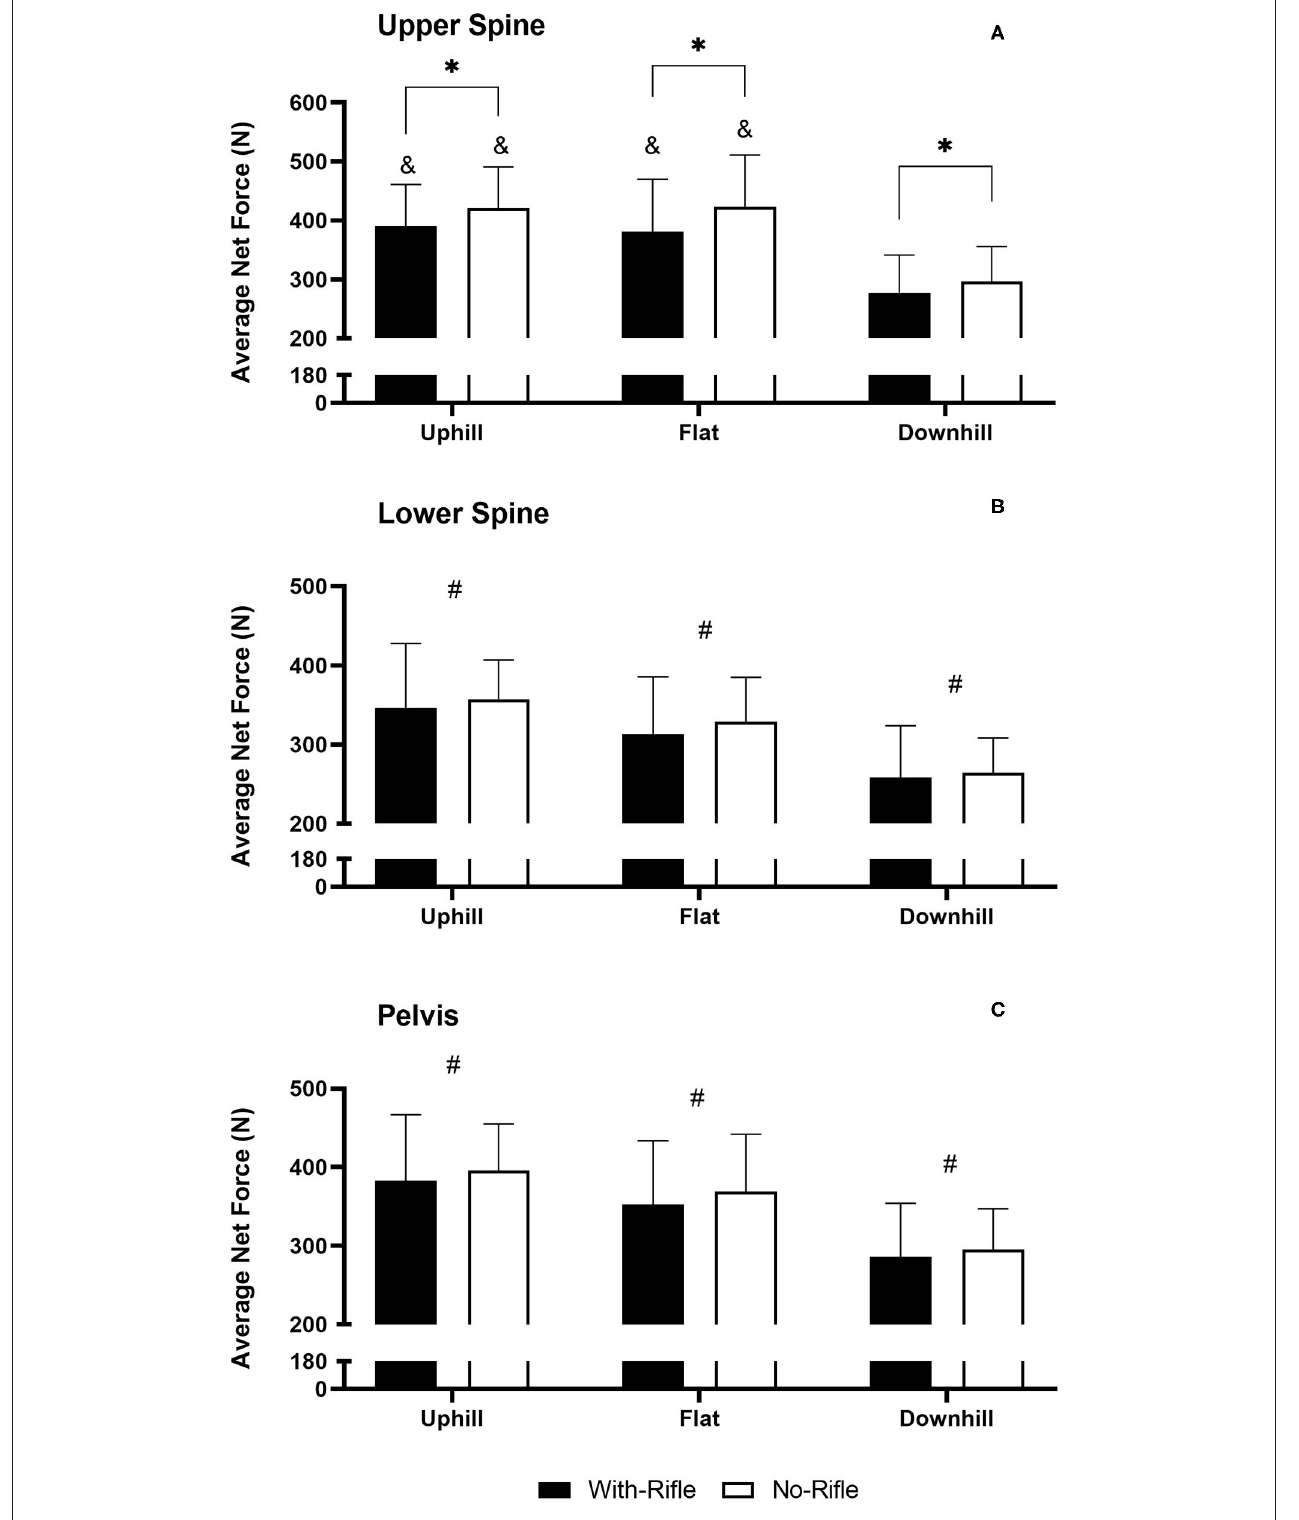
FIGURE 5 | Average Net Force With-Rifle and No-Rifle for all gradients for each sensor position. (A) Upper Spine; (B) Lower Spine; and (C) Pelvis. Mean ± standard deviation. *different to With-Rifle within condition ( p ≤ 0.003); # different to all other gradients ( p < 0.001); & different to Downhill within condition ( p < 0.001).